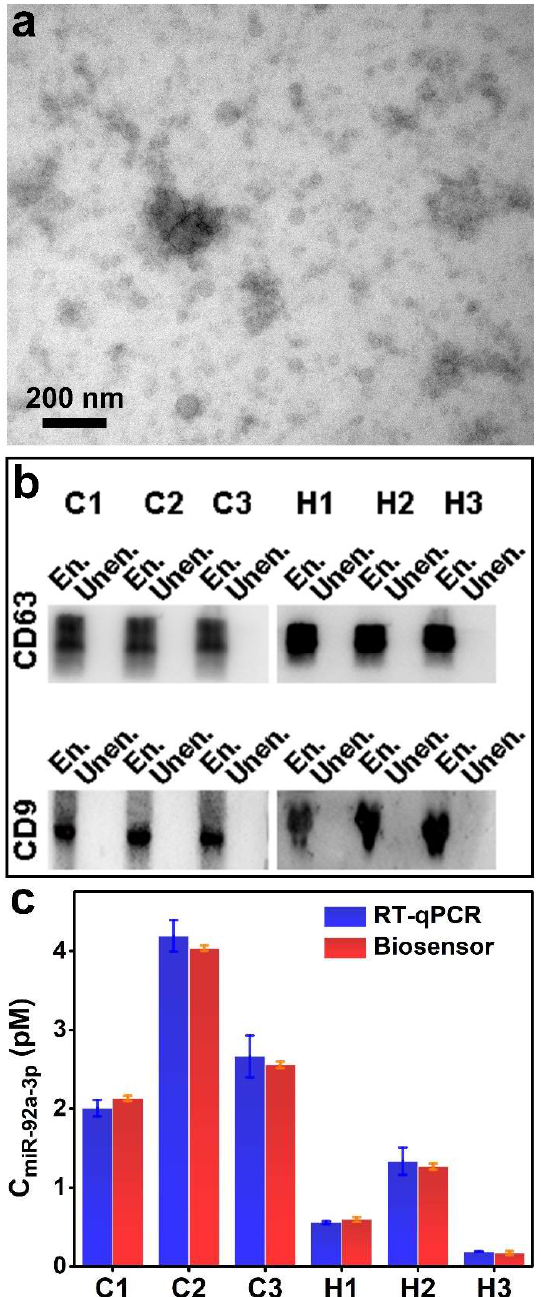
Figure 6. ( a ) TEM image of exosomes. ( b ) Western blotting of exosome-enriched (En.) and exosome- unenriched (Unen.) samples. C1 ~ C3 represent CRC patients; H1 ~ H3 represent healthy controls. ( c ) Comparison of the concentration of exosomal miR-92a-3p of three CRC patients and three healthy controls detected by RT-qPCR and the proposed biosensor ( n = 3, mean ± s.d.). To verify the accuracy of our fabricated biosensor, RT-qRCR and the ratiometric flu- orescent biosensor were used in parallel to detect the concentration of miR-92a-3p ex- tracted from exosomes. As shown in Figure 6c, the detection results of the ratiometric fluorescent biosensor are consistent with those of RT-qPCR, demonstrating that our fab- ricated biosensor possesses high accuracy and practicality. In addition, the detection re- sults of the ratiometric fluorescent biosensor showed higher stability than RT-qPCR.